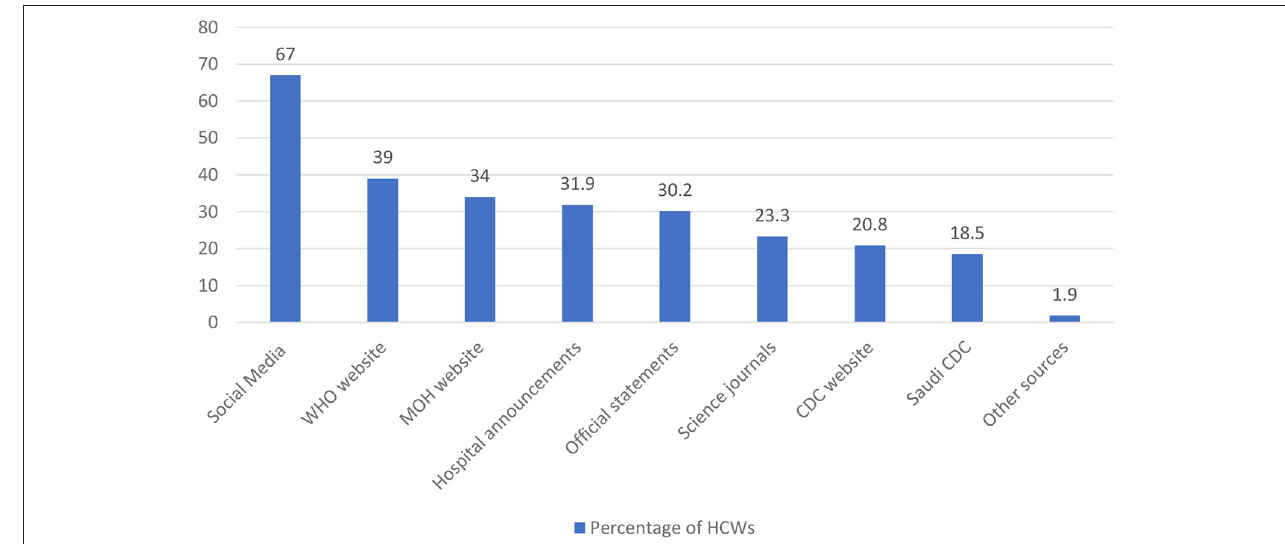
FIGURE 1 | HCWs’ sources of information about the B.1.1.7 SARS-CoV-2 mutant variant.